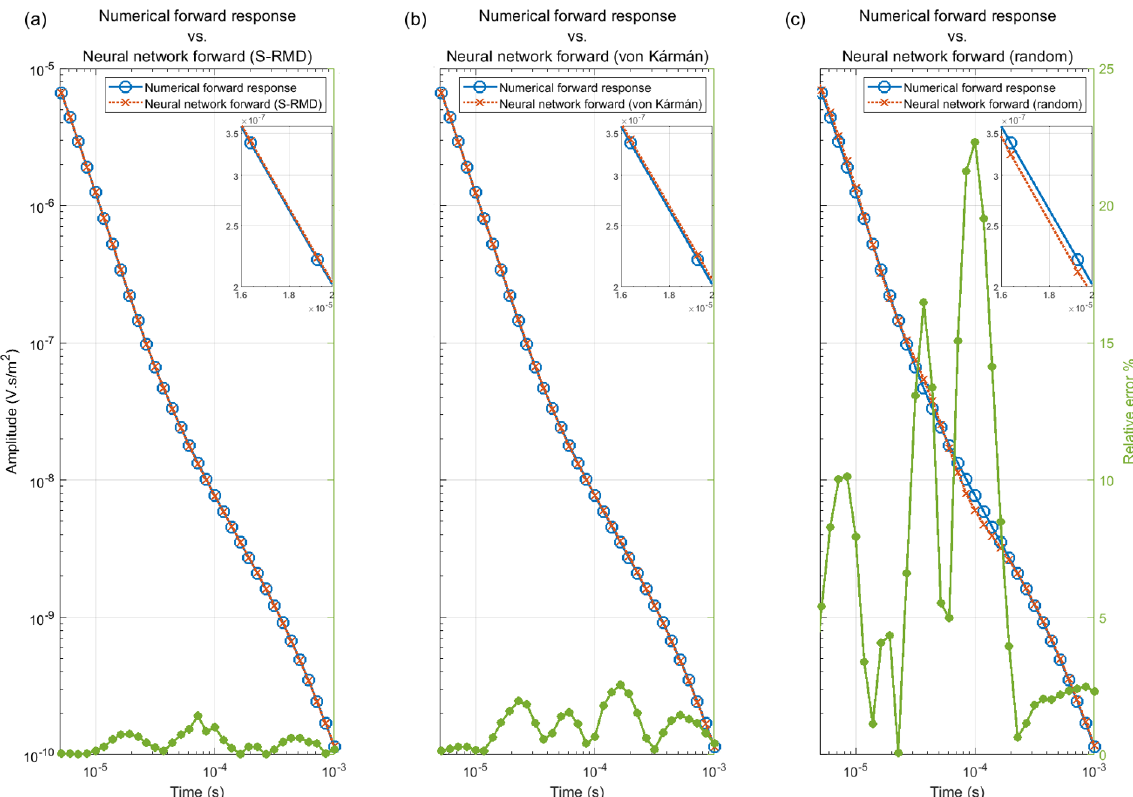
Figure 4. Comparison of performance of the networks trained on S-RMD, von Kármán models, and random resistivity models with a numerical forward response from the test set. The forward responses are shown only within the time range of tTEM data, and the inset shows the forward response from 16 to 20µs (a) Numerical forward response vs. the forward response from the network trained on S-RMD. (b) Numerical forward response vs. the forward response from the network trained on von Kármán models. (c) Numerical forward response vs. the forward response from the network trained on random resistivity